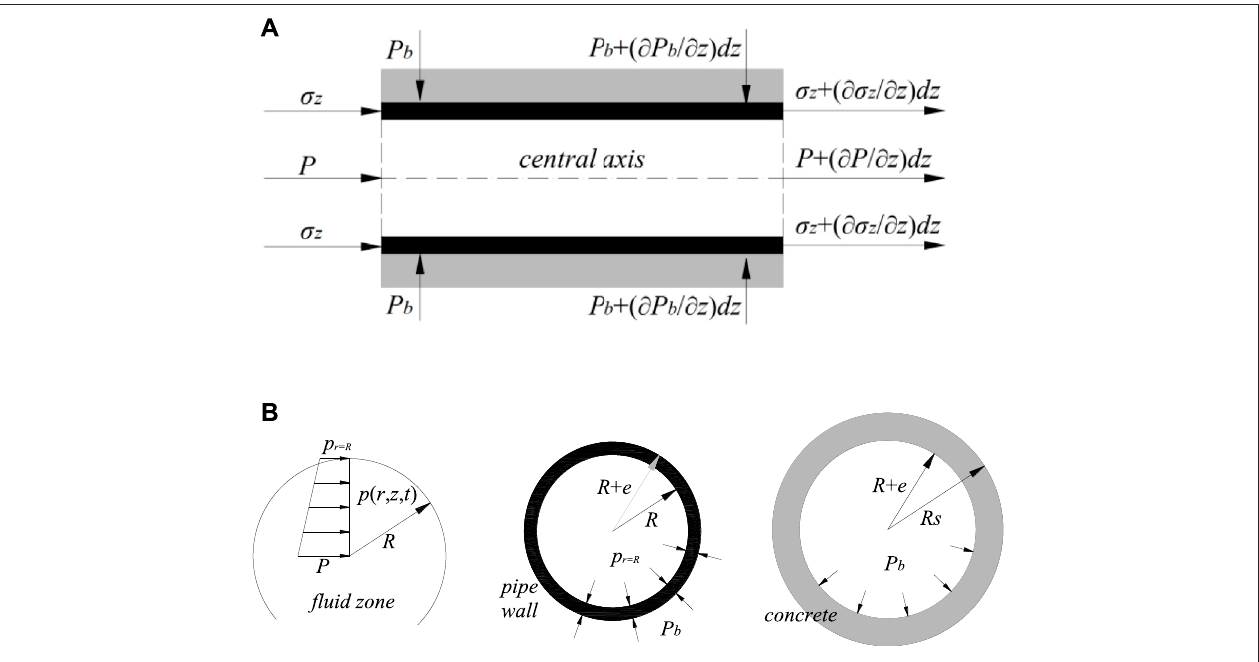
FIGURE 1 | Sketch of stress acting on pipe wall. (A) Side view. (B) Cross-sectional view.